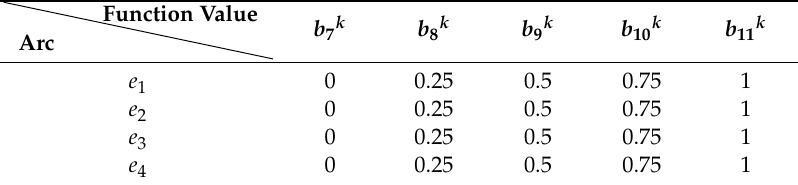
Table 7. Fuzzy function value of reliability for each